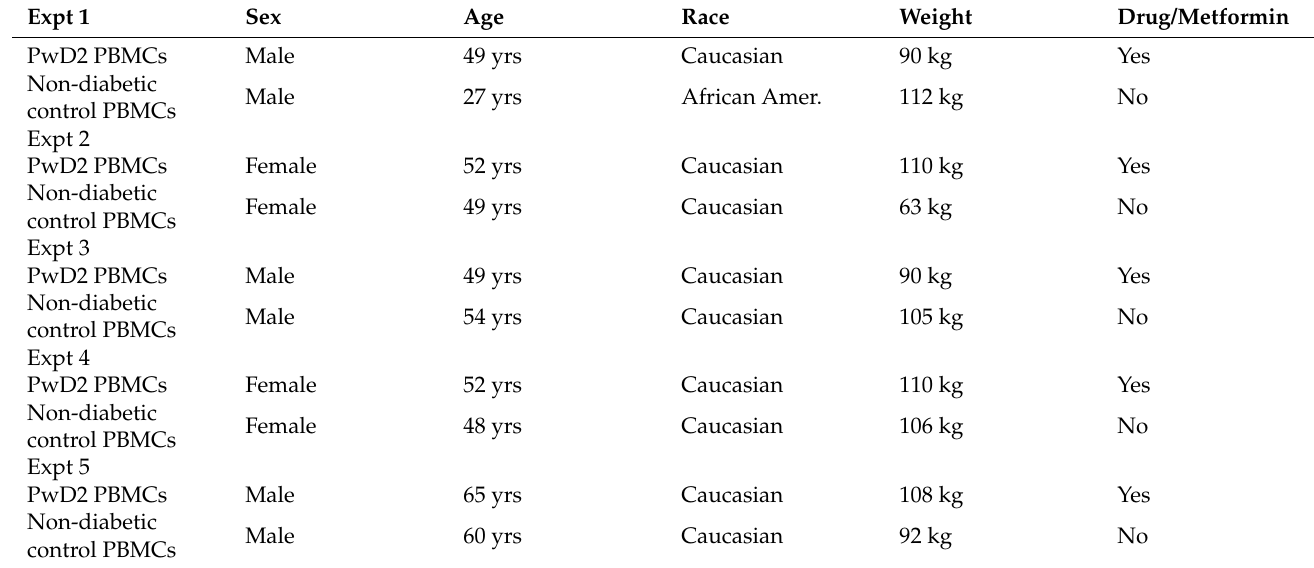
Table 3. PBMCs were chosen from PwD2, and non-diabetic controls as